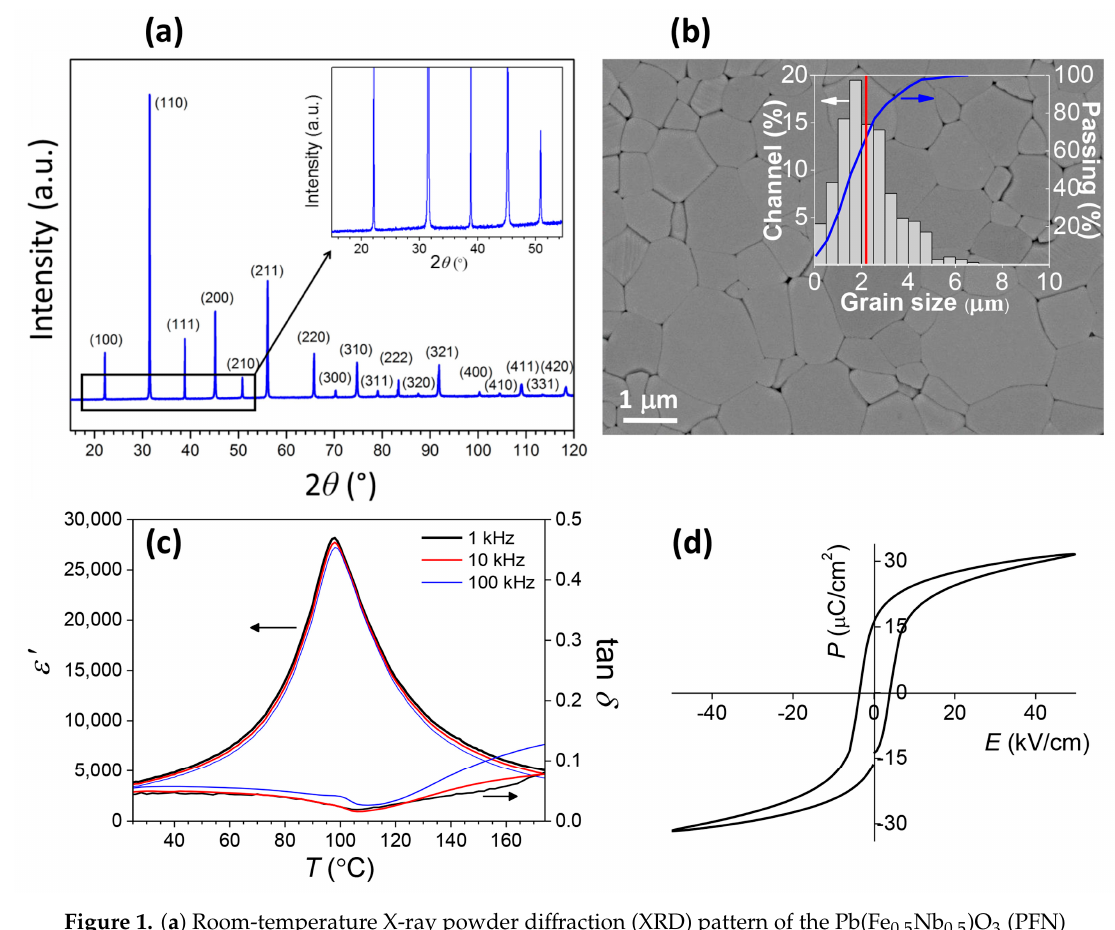
Figure 1. ( a ) Room-temperature X-ray powder di ff raction (XRD) pattern of the Pb(Fe 0.5 Nb 0.5 )O 3 (PFN) sample. The indexed peaks of the perovskite phase are shown in brackets (PDF card no. 032-0522 [16]). The inset shows an enlarged 2 θ region from 15 to 55 ◦ . ( b ) Field-emission scanning electron microscope (FE-SEM) micrograph of the thermally etched surface. Inset: The grain size distribution together with the cumulative curve. ( c ) The dielectric permittivity ε (cid:48) and dielectric losses tan δ versus temperature. ( d ) Polarisation–electric field ( P – E ) hysteresis loop at 25 ◦